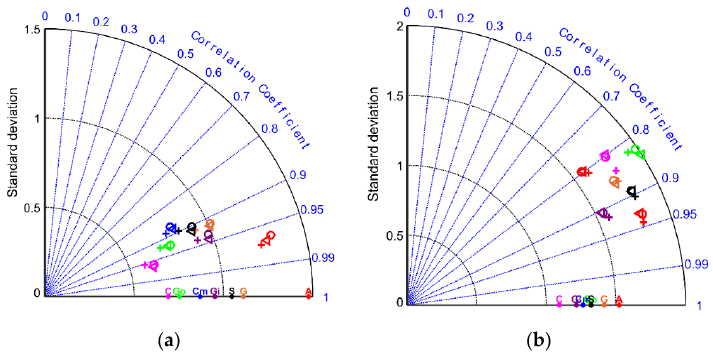
Figure 8. Taylor diagrams for the case studies in Table 3. Results for Hs ( a ) and Tm ( b) are reported. The plus (+), circle ( ◯ ) and triangle ( ⧍ ) symbols refer to the N scheme, PSI scheme and FCT scheme, respectively. Each buoy is represented by a different color: Alghero (A) in red, Capo Mele (Cm) in blue, Castiglione (C) in pink, Giannutri (Gi) in purple, Gombo (Go) in green, Gorgona (G) in orange and La Spezia (letter S) in black.